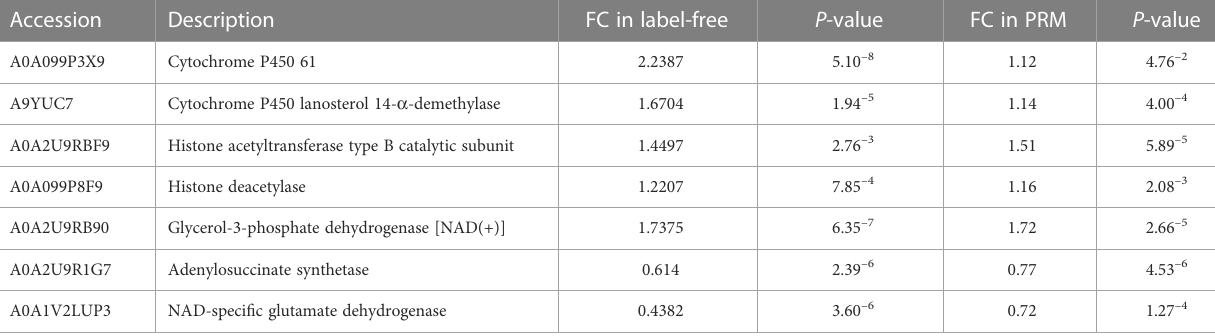
TABLE 2 Comparison of qualitative results between label-free proteomics and